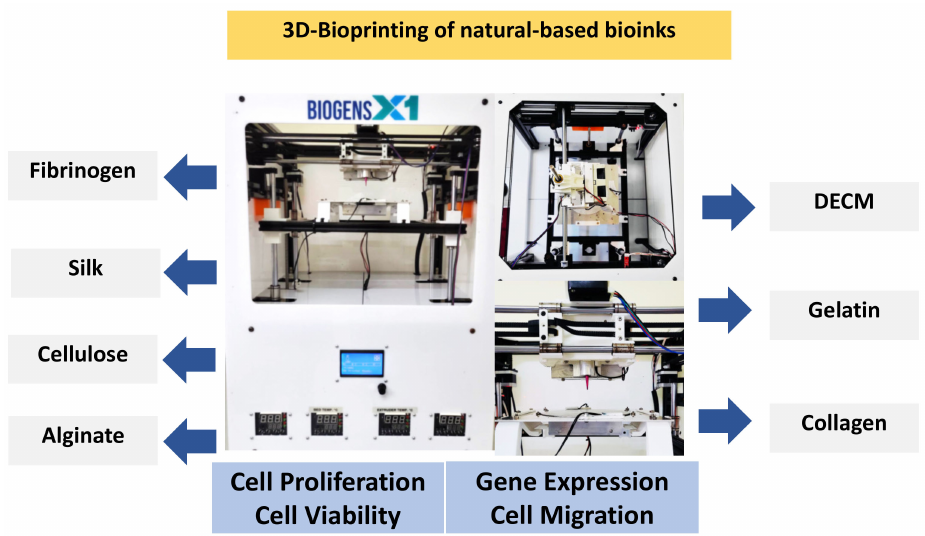
Figure 7. Cellular activities that the bioinks can